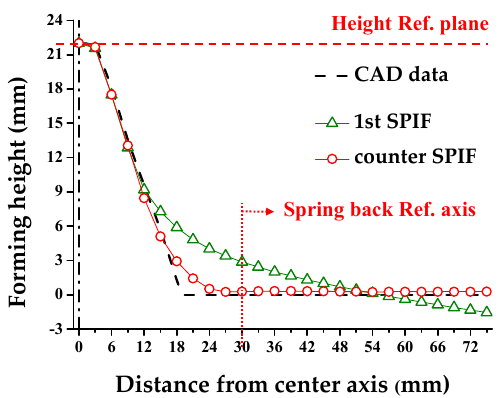
Figure 18. Experimental results of the ship-hull shape after ( a ) the 1st and ( b ) the counter SPIF processes.